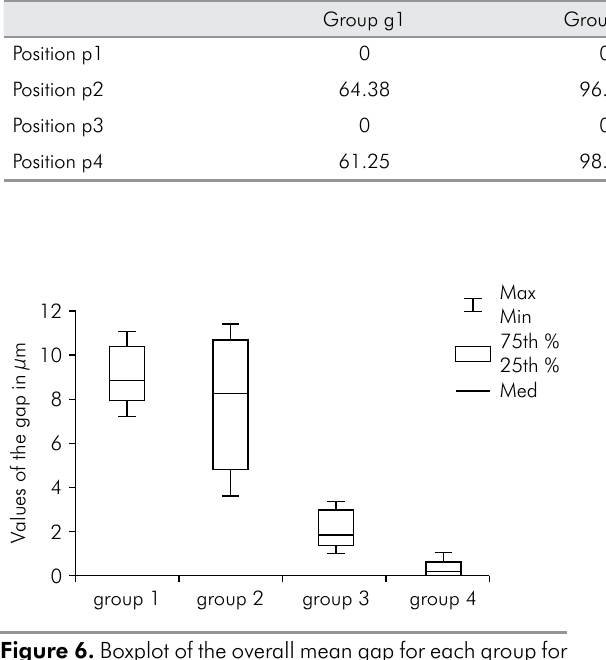
Table 3. Measurements of the areas of linear contact between the internal walls of the abutments and implants at the preset positions (expressed in percentages).